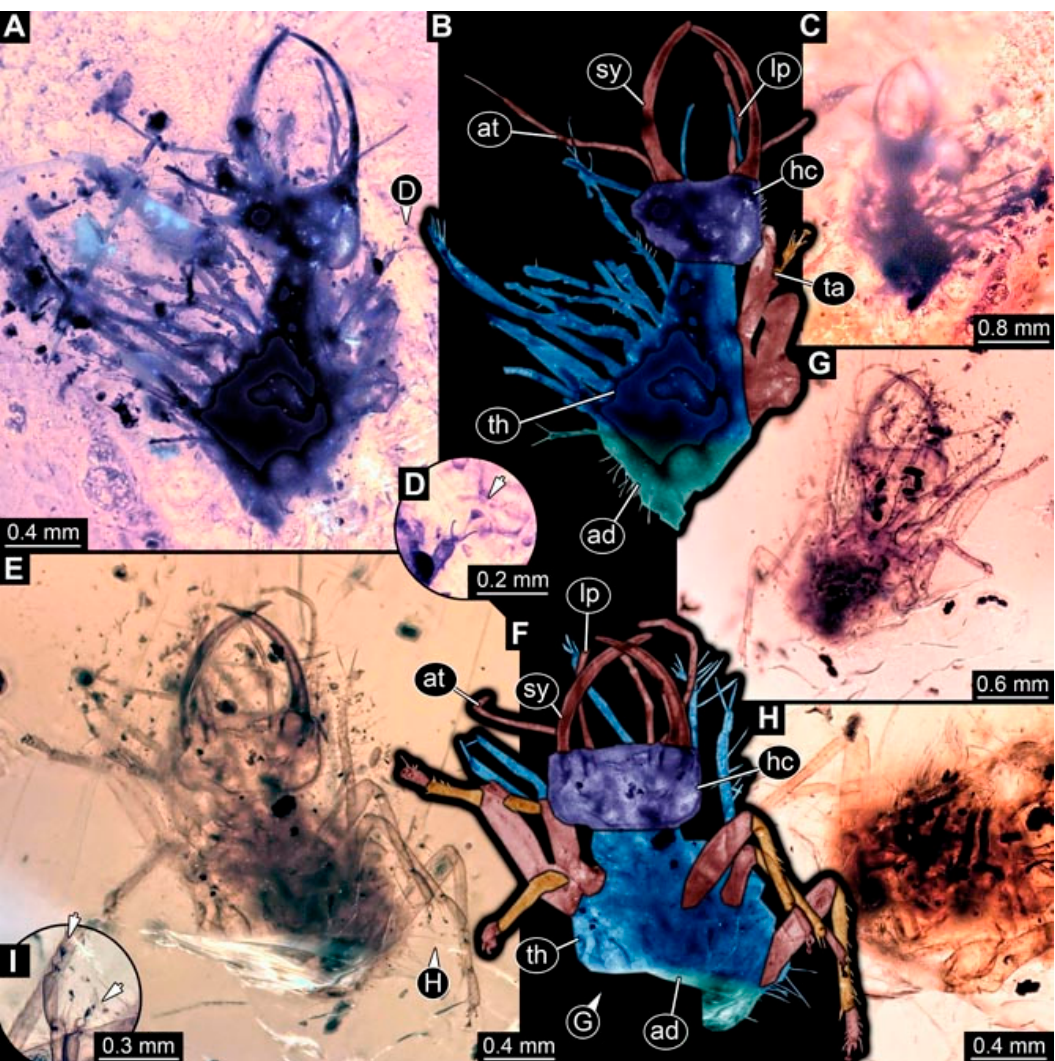
Figure 39. Two specimens in Myanmar amber. ( A – C ) Specimen 4867 (PED 1258a). ( A ) Dorsal view. ( B ) Dorsal view, colour-marked. ( C ) Ventral view. ( D ) Close-up of trunk appendage with empodium (arrow). ( E – I ) Specimen 4868 (PED 1258b). ( E ) Ventral view. ( F ) Ventral view, colour-marked. ( G ) Dorsal view. ( H ) Close-up of trunk in dorsal view. ( I ) Close-up of trunk appendages with empodia (arrows). Abbreviations: ad = abdomen; at = antenna; hc = head capsule; lp = labial palp; sy = stylet; ta = tarsus; th = thorax.